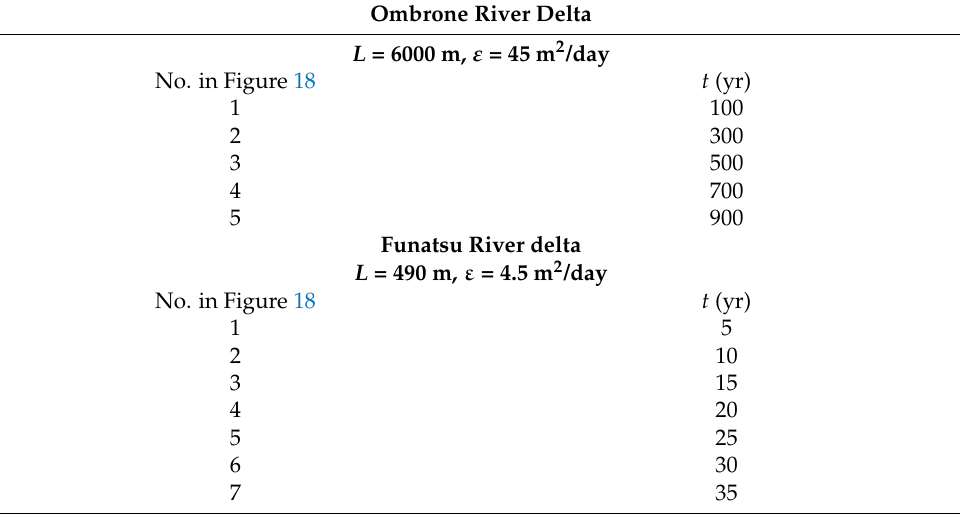
Table 5. Spatial and temporal scales of the Ombrone River and the Funatsu River deltas.